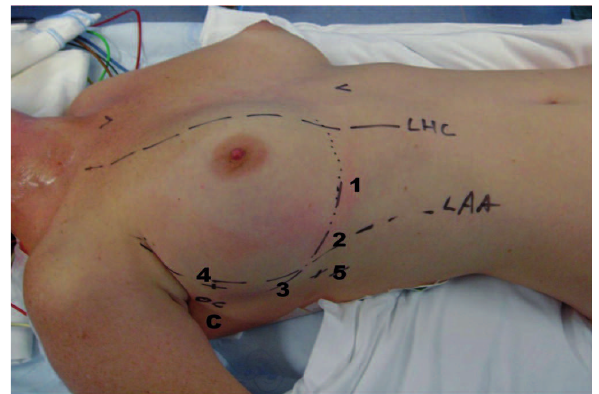
Fig. 1 - Marcações pré-operatórias e os locais para introdução de: 1. afastador atrial direito, 2. óptica, 3. trocarte de trabalho, 4.